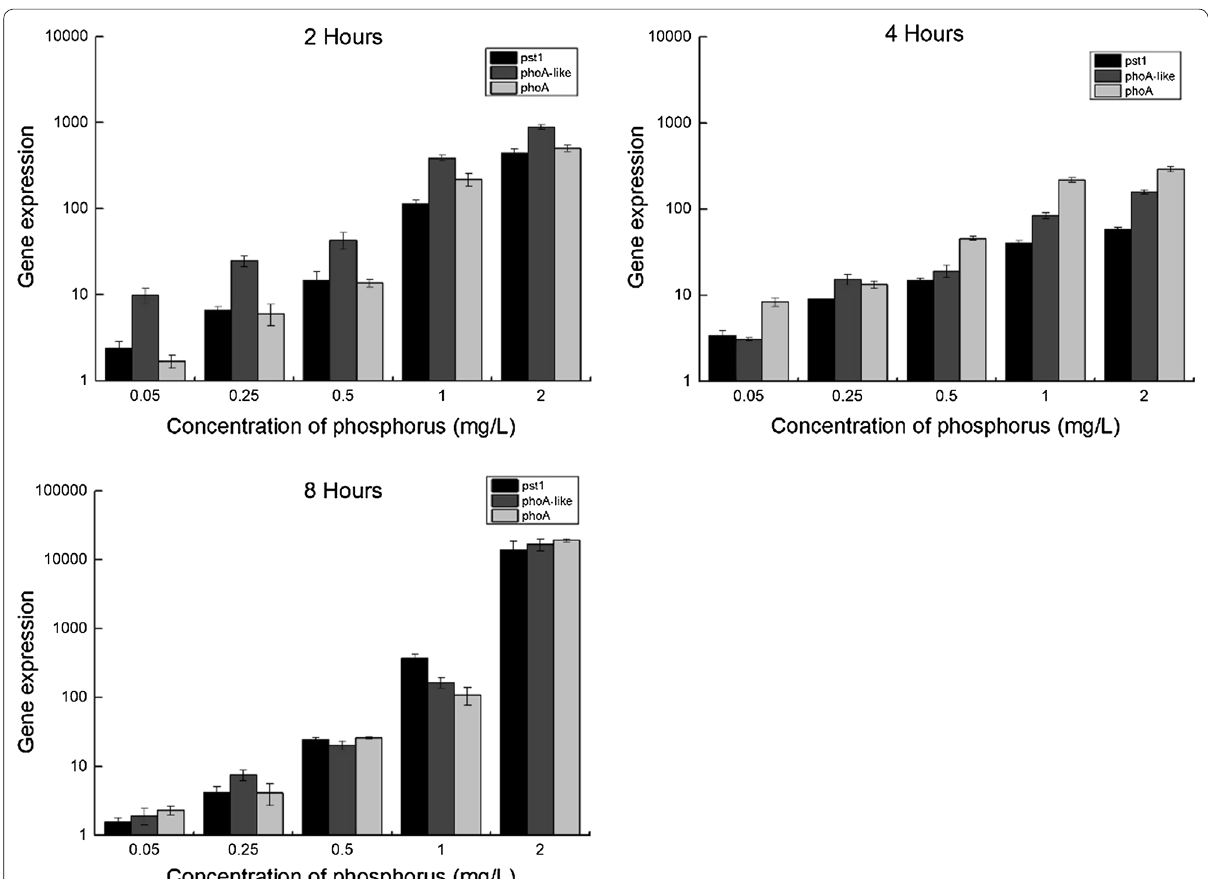
Fig. 3 Gene expression of the three studied genes ( phoA / phoA - like / pst1 ) in response to phosphorus (K 2 HPO 4 ) exposure after 2, 4, and 8 h of incubation